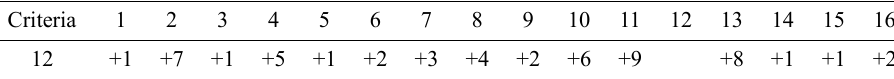
Table 5. The relationship between the sixteenth main criterion determined by the experts